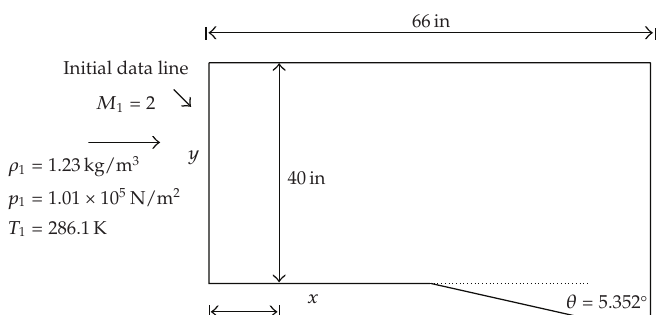
Figure 3: Expansion corner initial